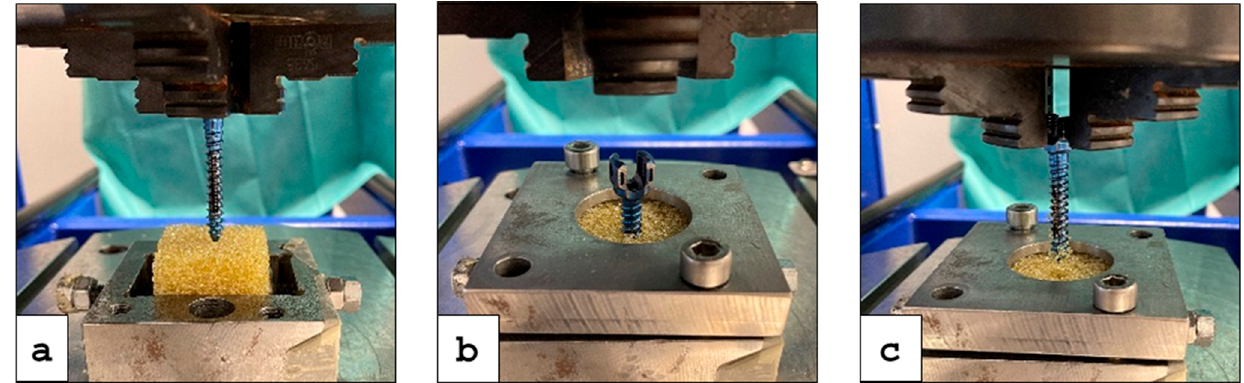
Figure 7. Test procedure: ( a ) Insertion of the functionalized pedicle screw in the artificial bone (yellow block); ( b ) Activation of the NiTi SMA strips (anchoring elements); ( c ) Pullout-test of the screw.